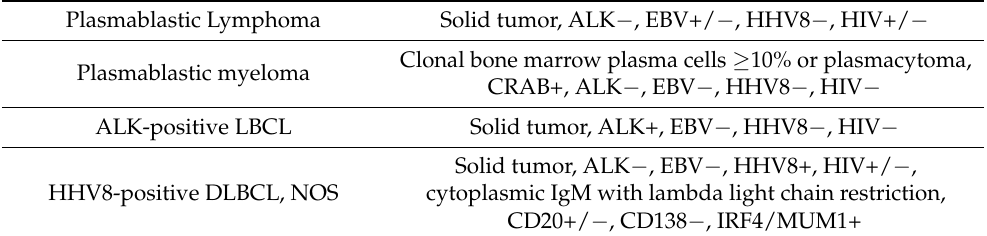
Table 4. Differential diagnoses of PEL with a plasmablastic phenotype. Plasmablastic Lymphoma